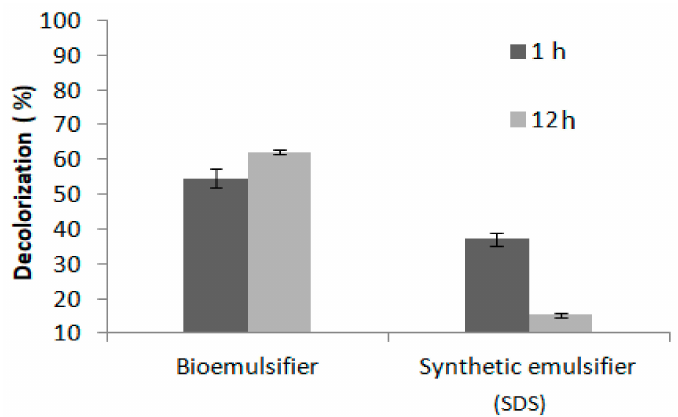
Figure 4. Methylene blue dye removal by the bioemulsifier produced from Bacillus subtilis during 1 h and 12